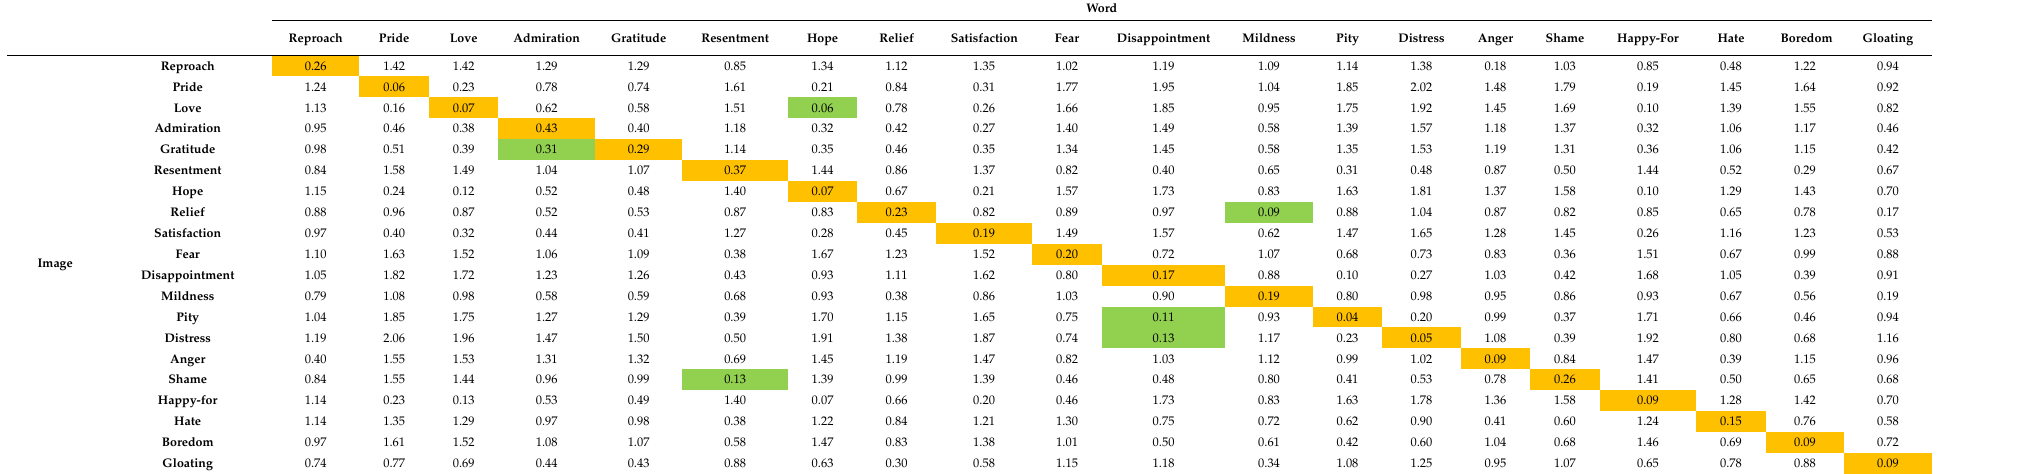
Table 3. The PAD Euclidean distance between 20 images and 20 emotional words in validation